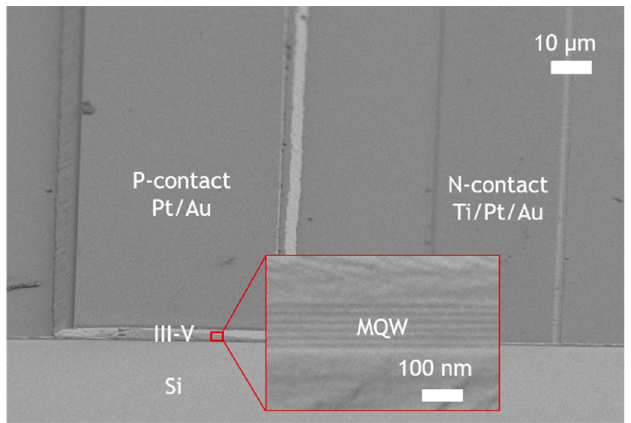
Figure 5. Cleaved bar of a broad-area laser on InPoSi observed by SEM with an insert observation in the MQW region .